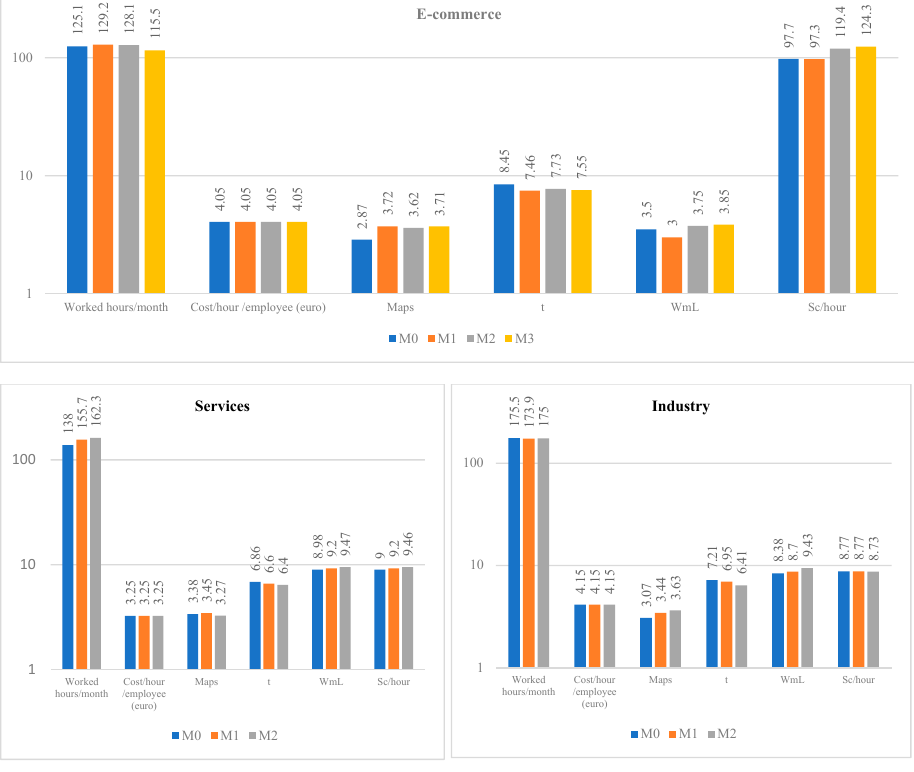
Figure 5. Evolution of the Spc indicator elements/variables—average values/moment for each sector.